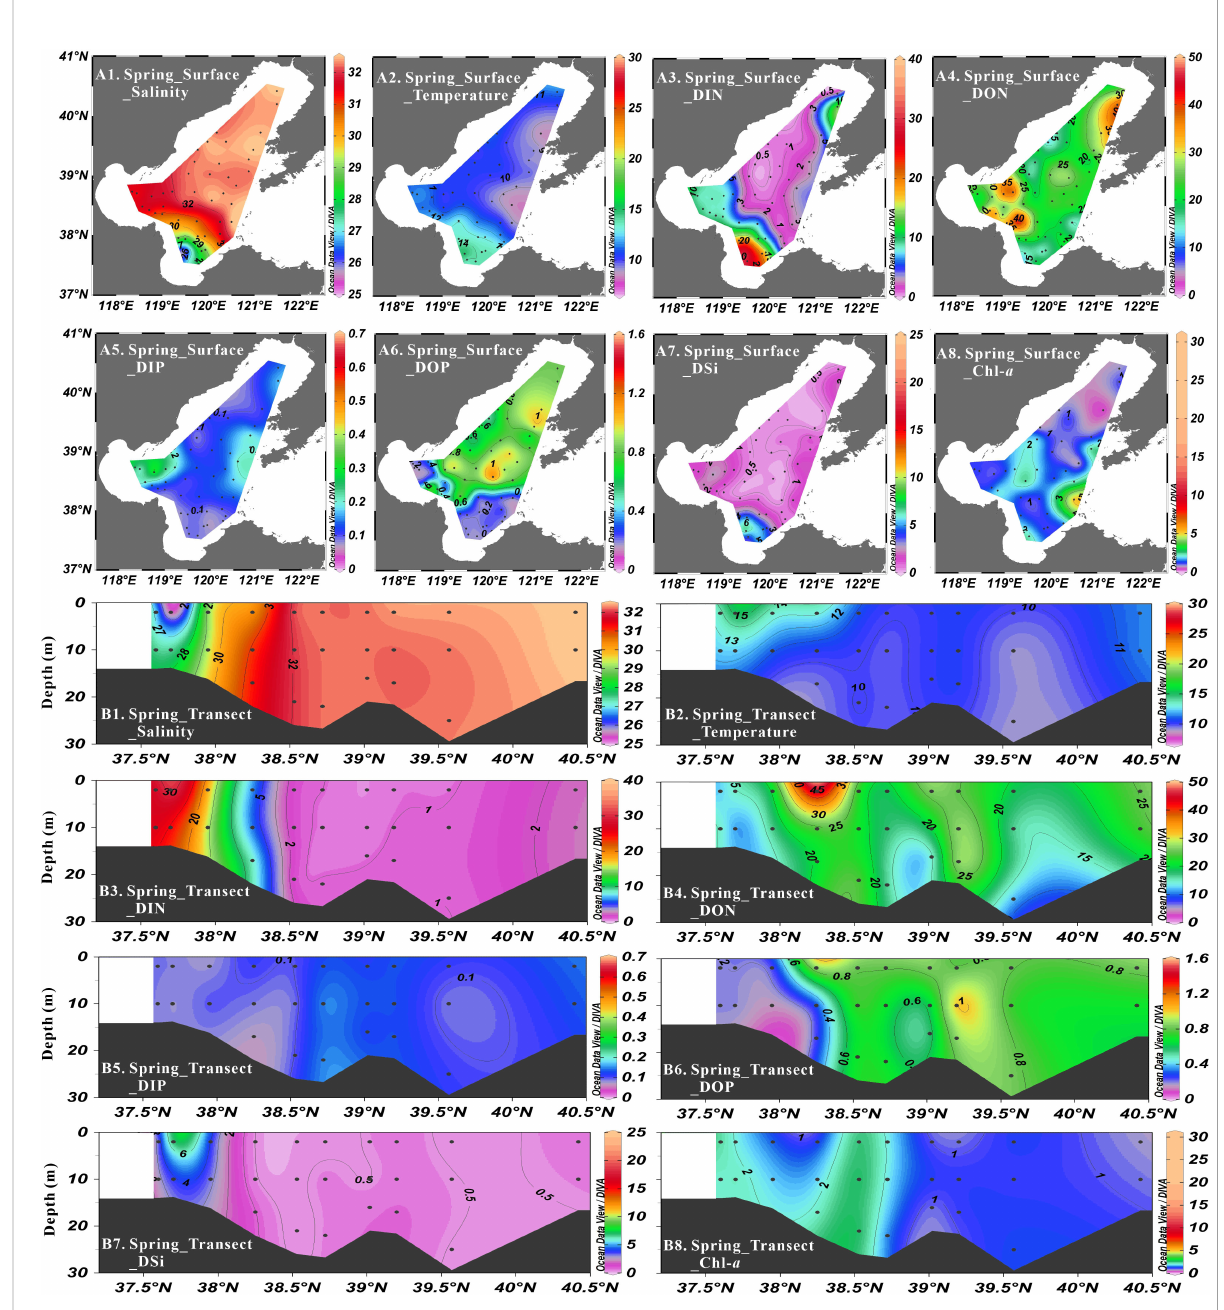
FIGURE 2 Distribution of salinity (psu), temperature (°C), DIN concentration ( m mol·L -1 ), DON concentration ( m mol·L -1 ), DIP concentration ( m mol·L -1 ), DOP concentration ( m mol·L -1 ), DSi concentration ( m mol·L -1 ) and Chl- a concentration ( m g·L -1 ) at surface layer (A1-A8) and Northeast-Southwest transect (B1-B8) in